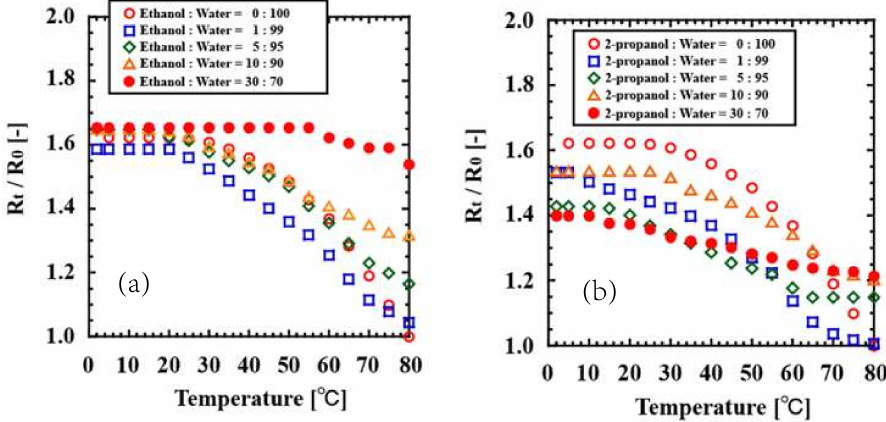
Figure 5. LCST behavior of the PTEGA gel in ( a ) aqueous ethanol and ( b ) aqueous